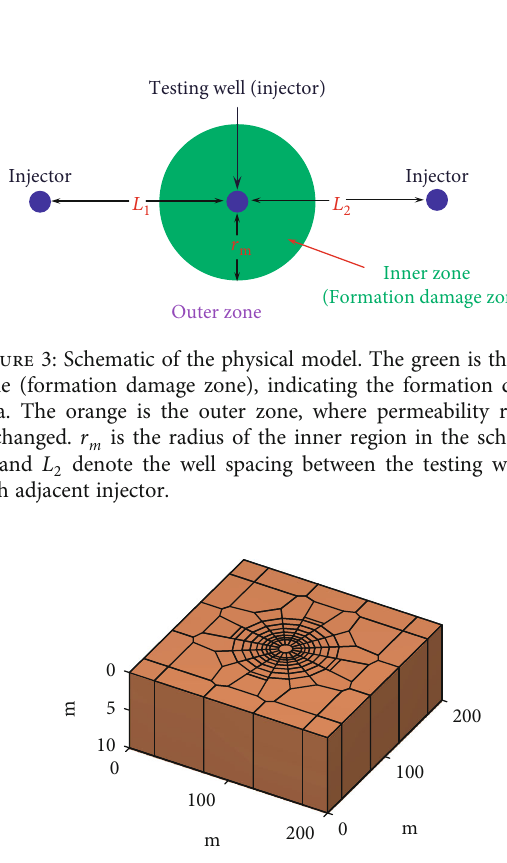
Figure 4: A hybrid grid system consisting of both Cartesian and radial